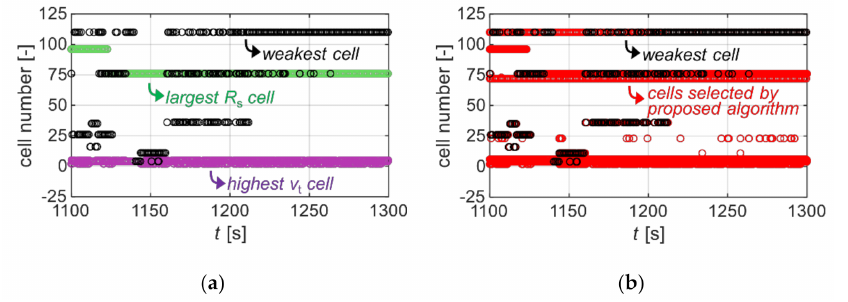
Figure 15. The cell number selected by the screening algorithm in the time interval of 1100.0–1300.0 s: ( a ) based on the existing method in [21] and ( b ) based on the proposed